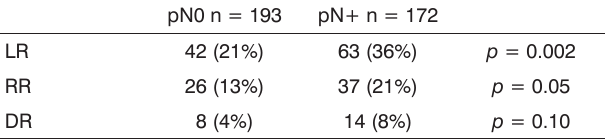
Table 2. Local (LR), regional (RR) and distance (RD) recurrence per pN